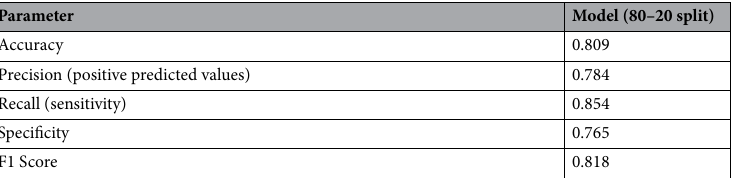
Table 1. Accuracy, Precision, Recall, Specificity and F1 score for Testing set 1 predictions using VGG16 LSTM trained model at 80-20 training-validation split, 100 epochs, 128 batch